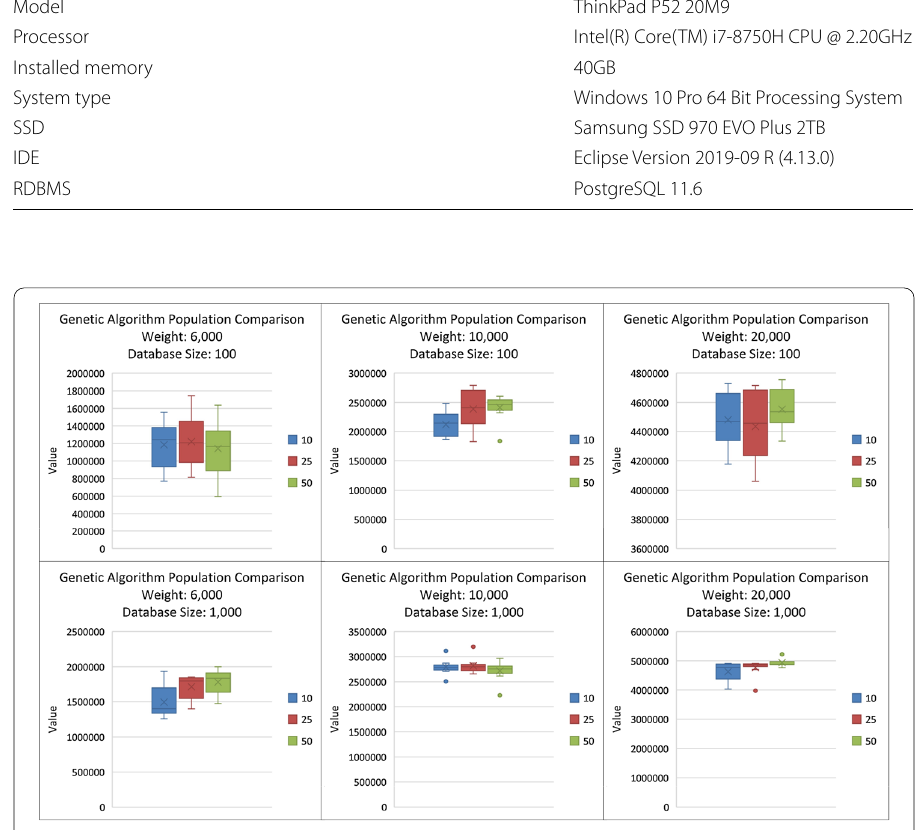
Fig. 2 Genetic Algorithm Population Comparison: Compares GA values with populations of 10, 25, and 50 with Databases of sizes 100 and